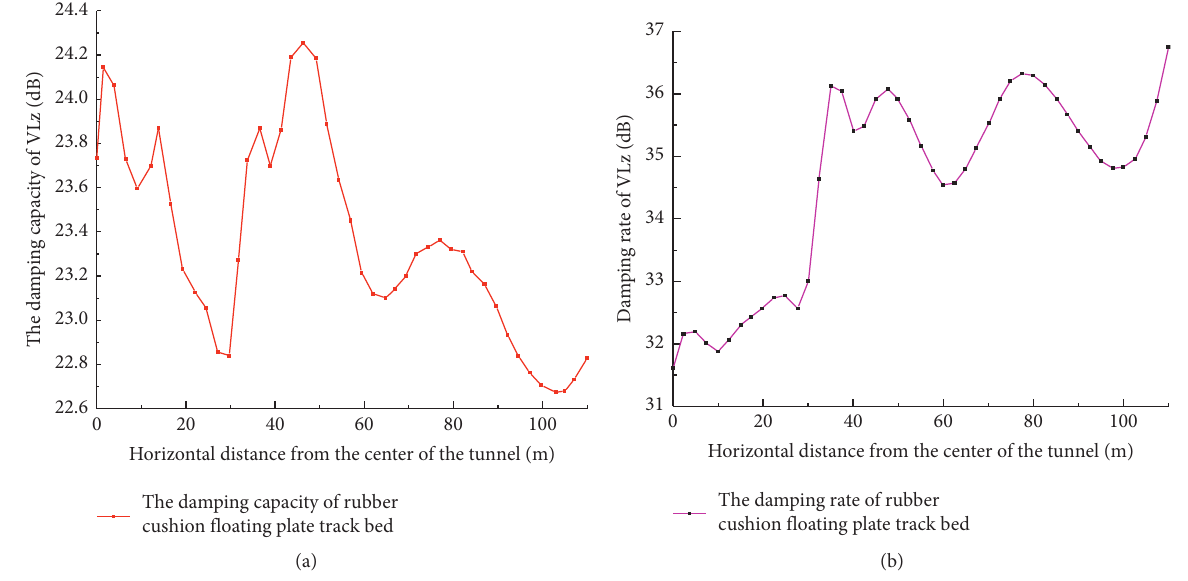
Figure 19: The variation law of damping capacity (a) and damping rate (b) of rubber cushion floating plate trackbed with horizontal